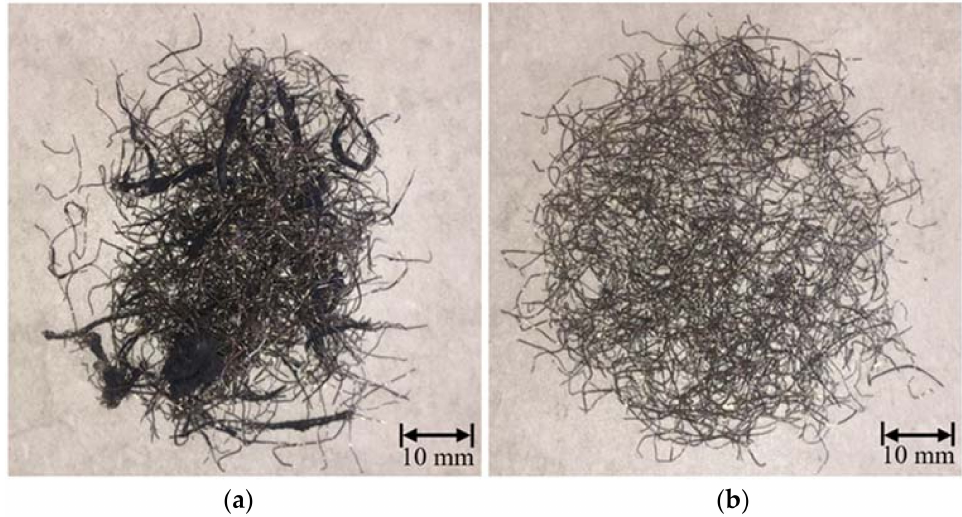
Figure 3. WTSF: ( a ) unclassified and ( b )